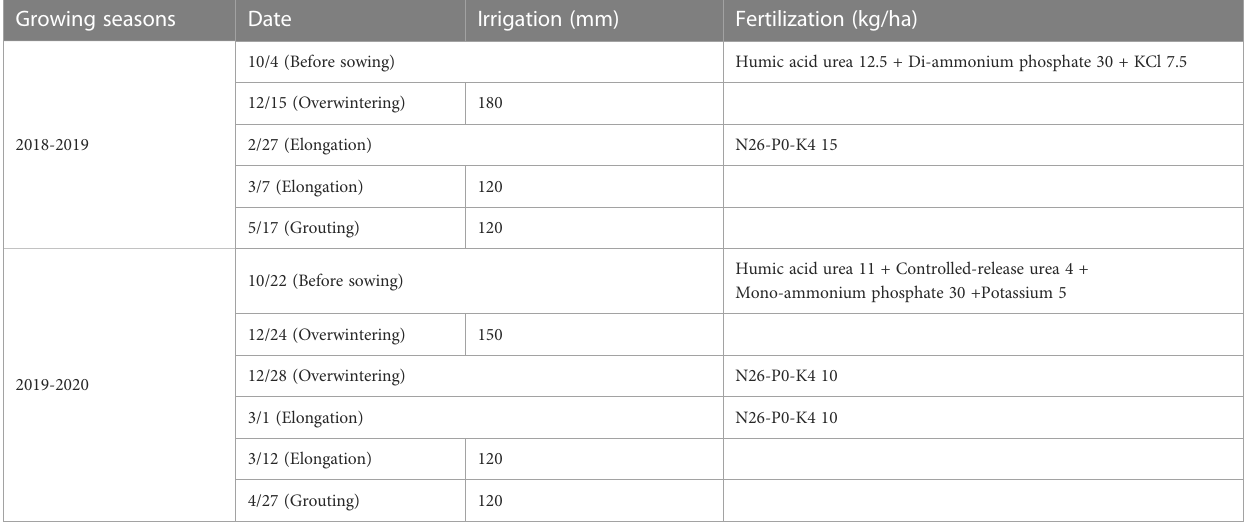
TABLE 1 On-farm management of 209 wheat varieties during the 2018-2019 and 2019-2020 growing seasons. Growing